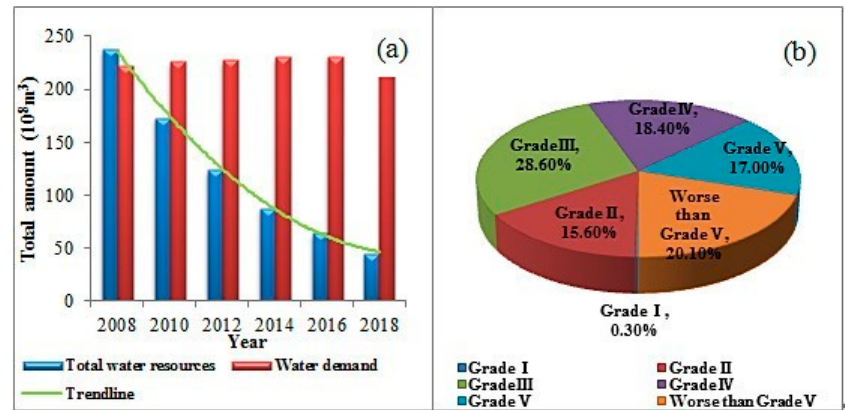
Figure 2. The states of water demand ( a ) and water quality ( b ) in Shandong.